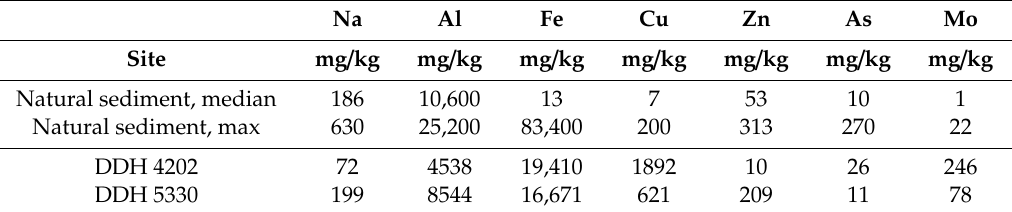
Table 2. Sediment chemistry at potentially artesian sites. Both sites had drill stems in a wetland with water pooled at the base. Testing was conducted to determine whether sites had elevated metals indicating artesian flow. “Natural Sediment” (n = 197) concentrations are from PLP [21].